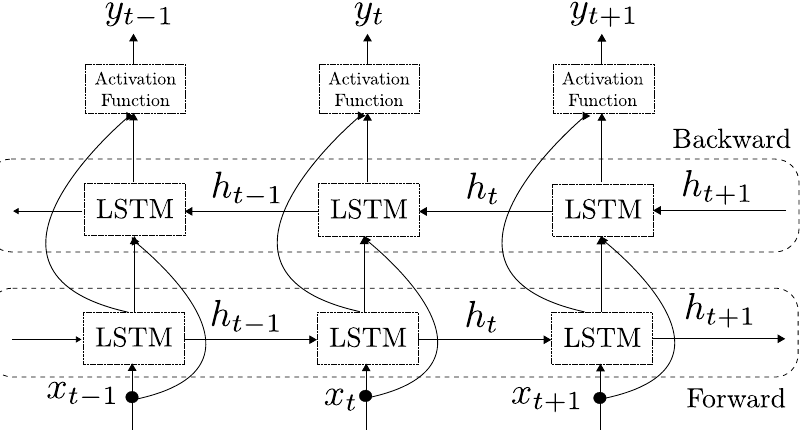
Figure 6. Bidirectional LSTM structure. Each LSTM unit in Figure 5 lines up in series in forward and backward layers in this structure. Note that the length of BLSTM is the same as the number of LSTM in the forward and backward